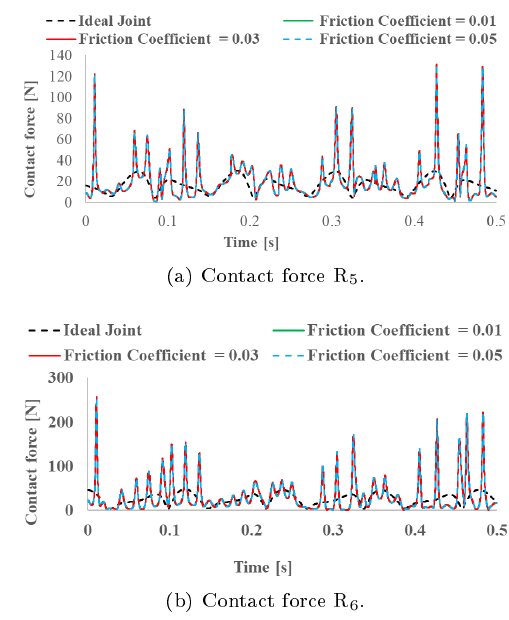
(b) Contact force R 6 . Fig. 13: Contact force at di(cid:27)erent friction coe(cid:30)cient.